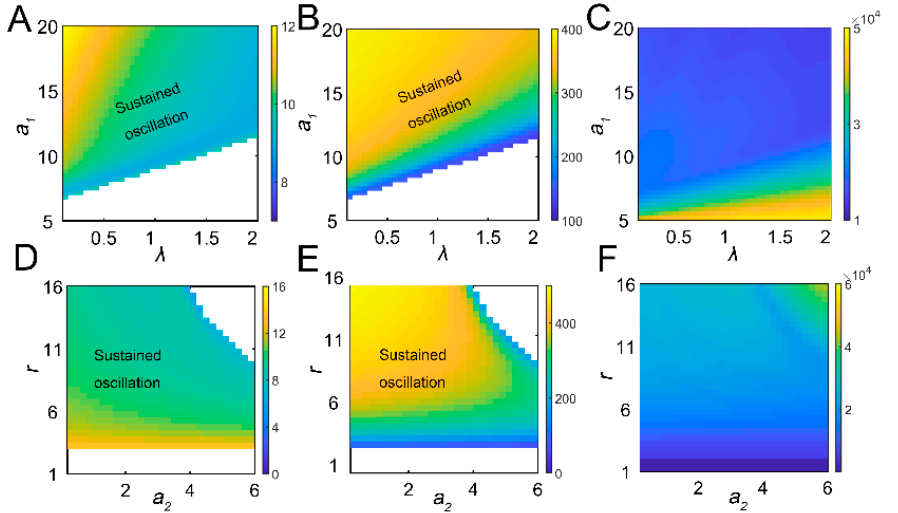
Figure 2. The global effect of parameters on dynamic responses. The combinatorial effects of a 1 and λ on period ( A ), amplitude ( B ), and tea crop integral ( C ). The regions of parametric combinations leading to sustained oscillation were marked as “sustained oscillation”. The combinatorial effect of a 2 and r on period ( D ), amplitude ( E ), and tea crop integral ( F ).